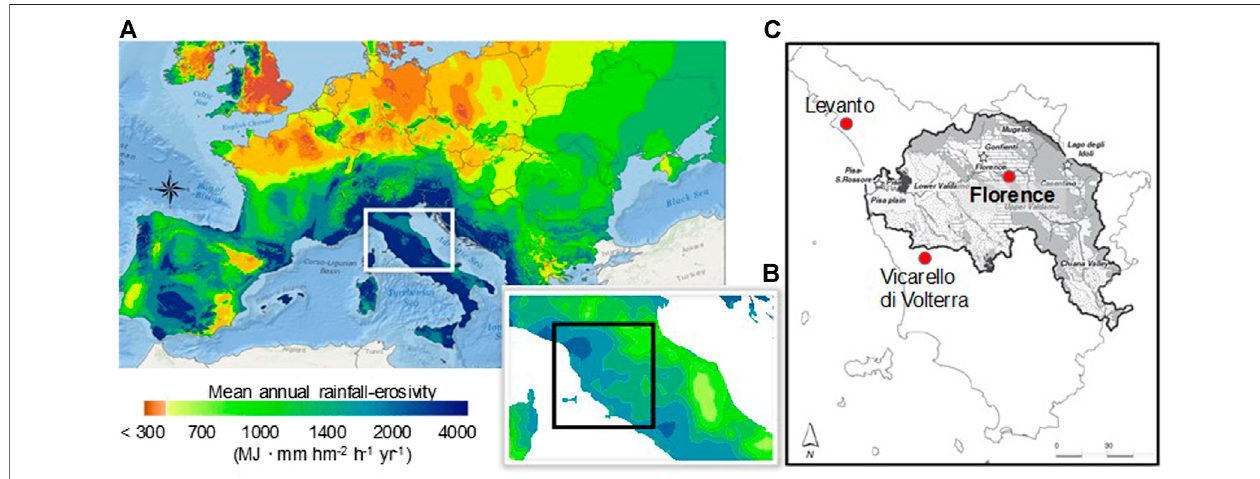
FIGURE1| Studyareaandenvironmental setting. (A) Spatialpattern ofmeanannualrainfallerosivityovercentral-southern Europeintheperiod 1994 – 2013(using Geostatistical Analytics by ArcGIS-ESRI on the European Soil Data Centre-dataset, https://esdac.jrc.ec.europa.eu/content/global-rainfall-erosivity, Panagos et al., 2015), (B) as (A) with focus on the Tuscany region (black square), and (C) Arno River Basin (in gray) with the pluviometric stations (red dots) providing the actual rainfall erosivity data used (following Benvenuti et al., 2011): Vicarello di Volterra (43 ° 24 ′ N, 10 ° 52 ′ E, 531 m a.s.l.), Levanto (44 ° 10 ′ N, 09 ° 36 ′ E, 3 m a.s.l.), Florence